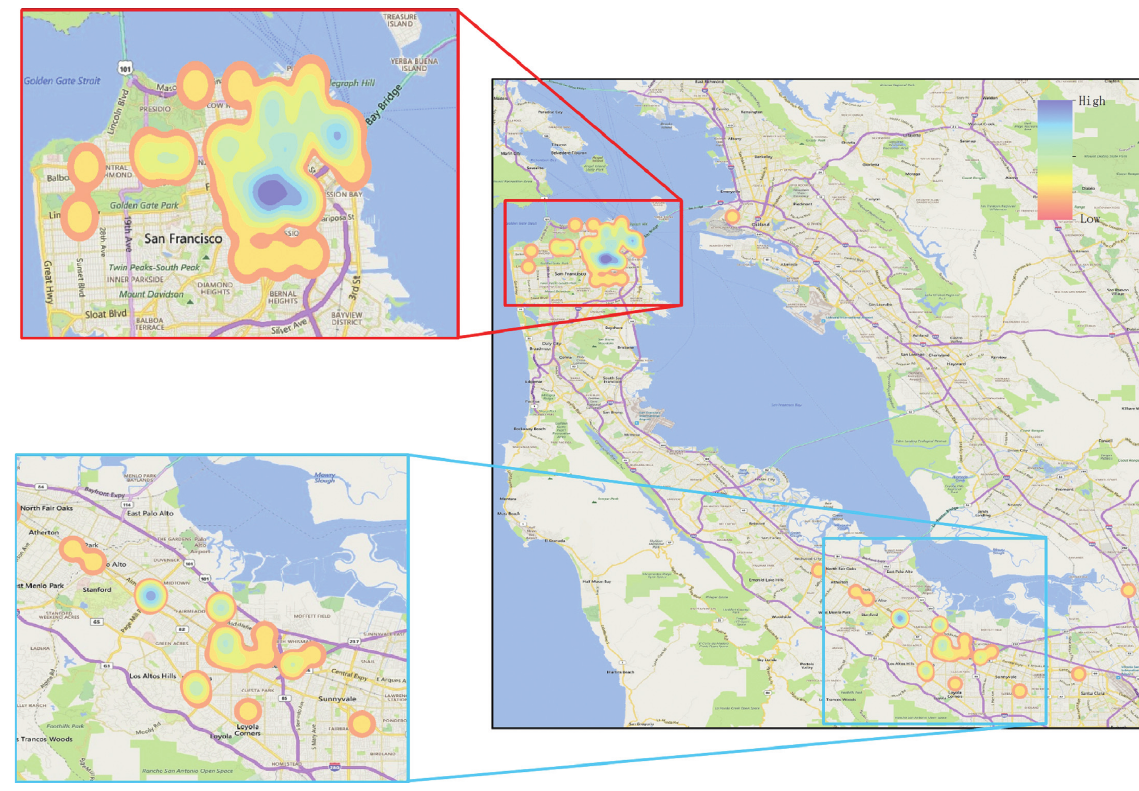
Figure 5: Heat map analysis of AV